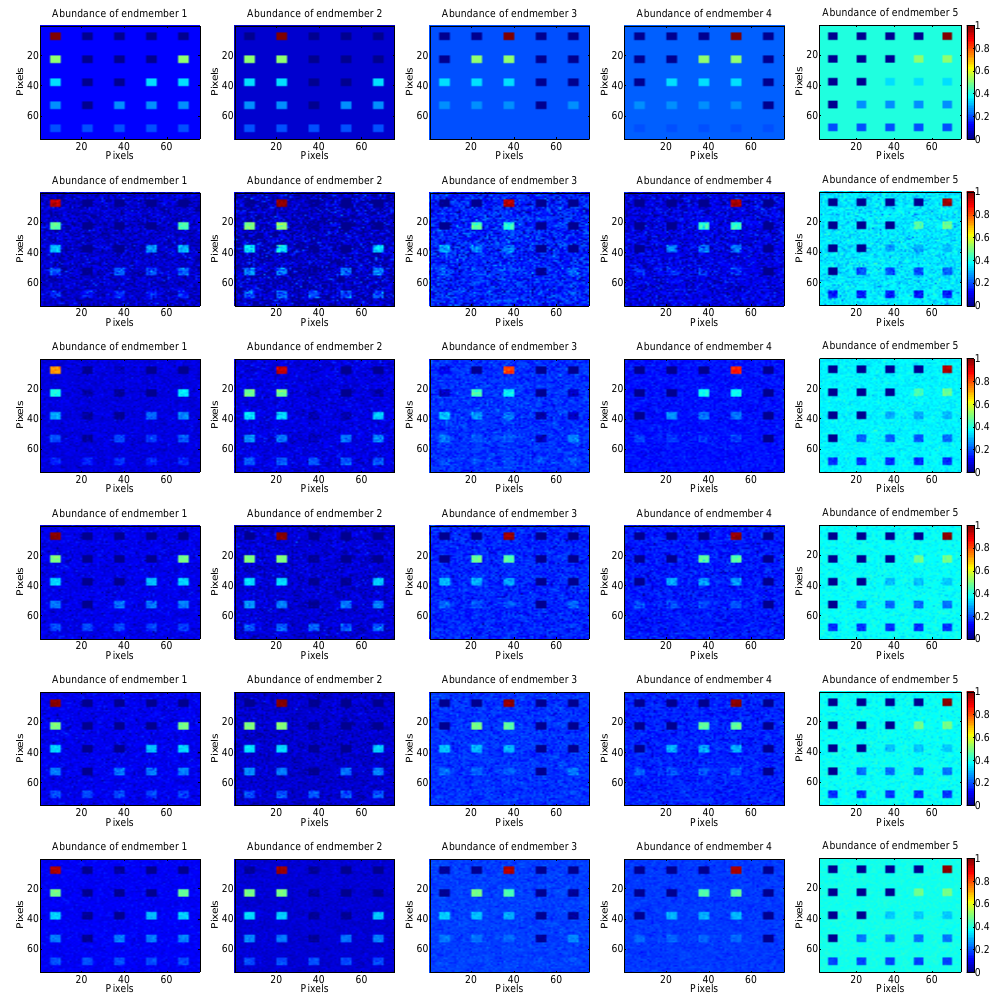
Figure 12. Abundance maps of five endmembers estimated with different methods under correlated noise with both pure and mixed regions having 75 × 75 pixels and 224 bands. From top to bottom: ground truth, SUnSAL ( λ = 10 − 2 ), CLSUnSAL ( λ = 1), CUSAL-SP ( λ = ˆ s × 10 − 3 ), SU-NLE ( d = 1) ( λ = 10 − 2 ) and SU-NLE ( d = 2) ( λ = 1).